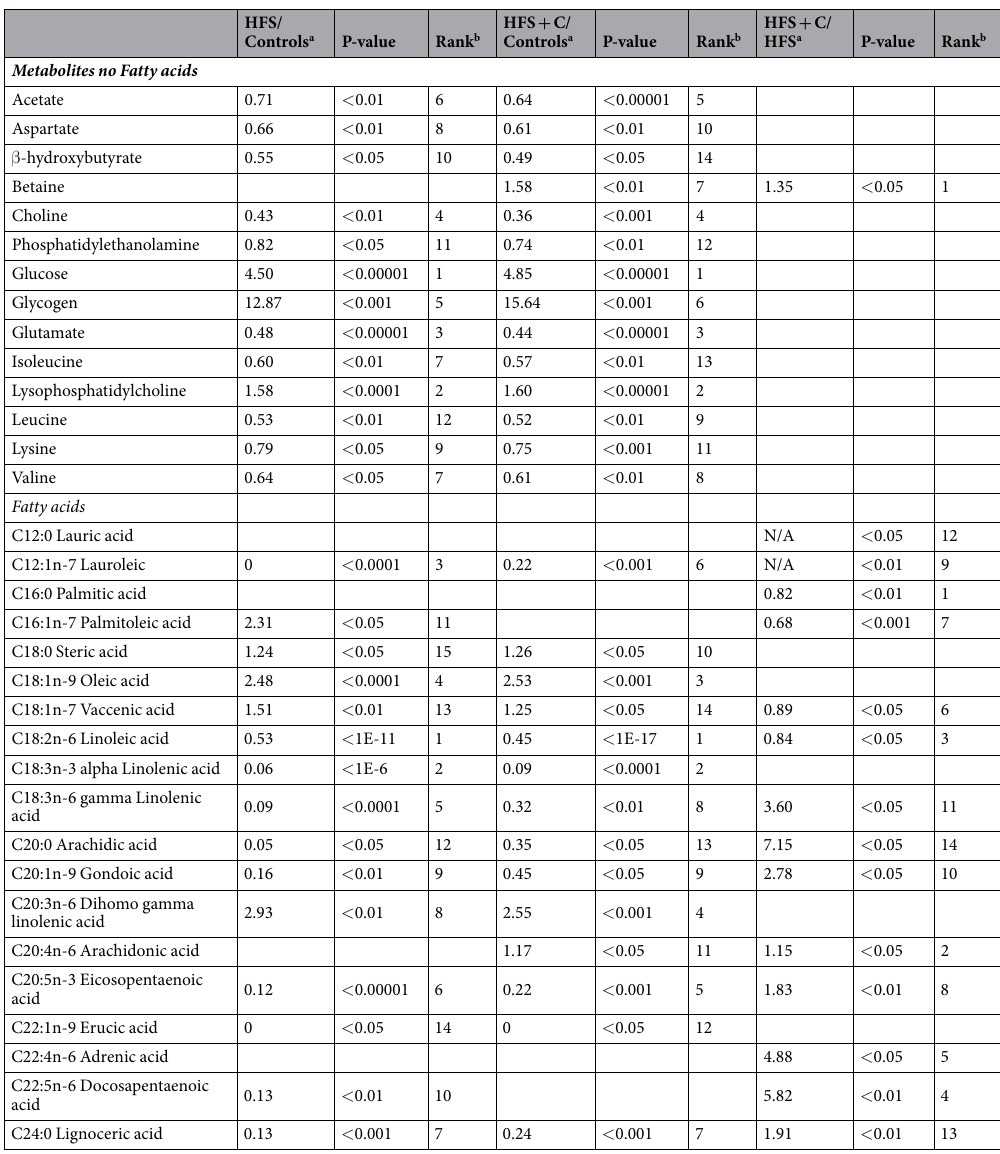
Table 3. Significantly differential metabolites in the rat liver of control, HFS and HFS + C group. The liver metabolites that contributed significantly to the discrimination between the different diets in the OPLS-DA models from the 1 H NMR data and GC/MS data. a Fold change in metabolite level followed by P-value and b Rank in variable importance projection (VIP). N/A not